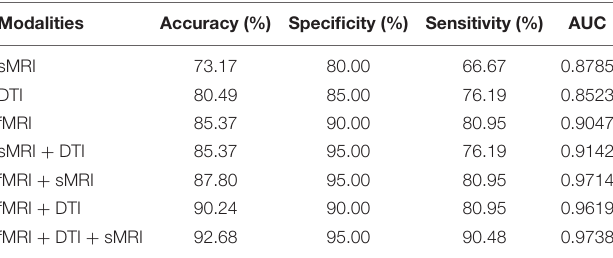
TABLE 4 | Classification performance of different